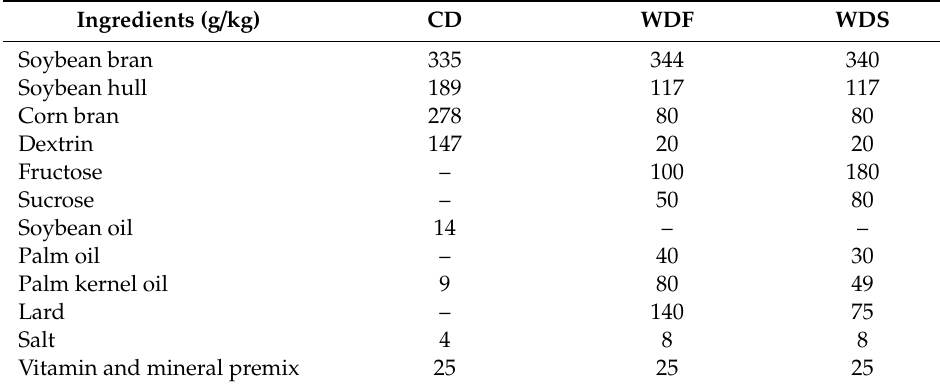
Table 1. Ingredients of Control diet (CD), Western diet fat (WDF), and Western diet sugar (WDS). Ingredients (g /